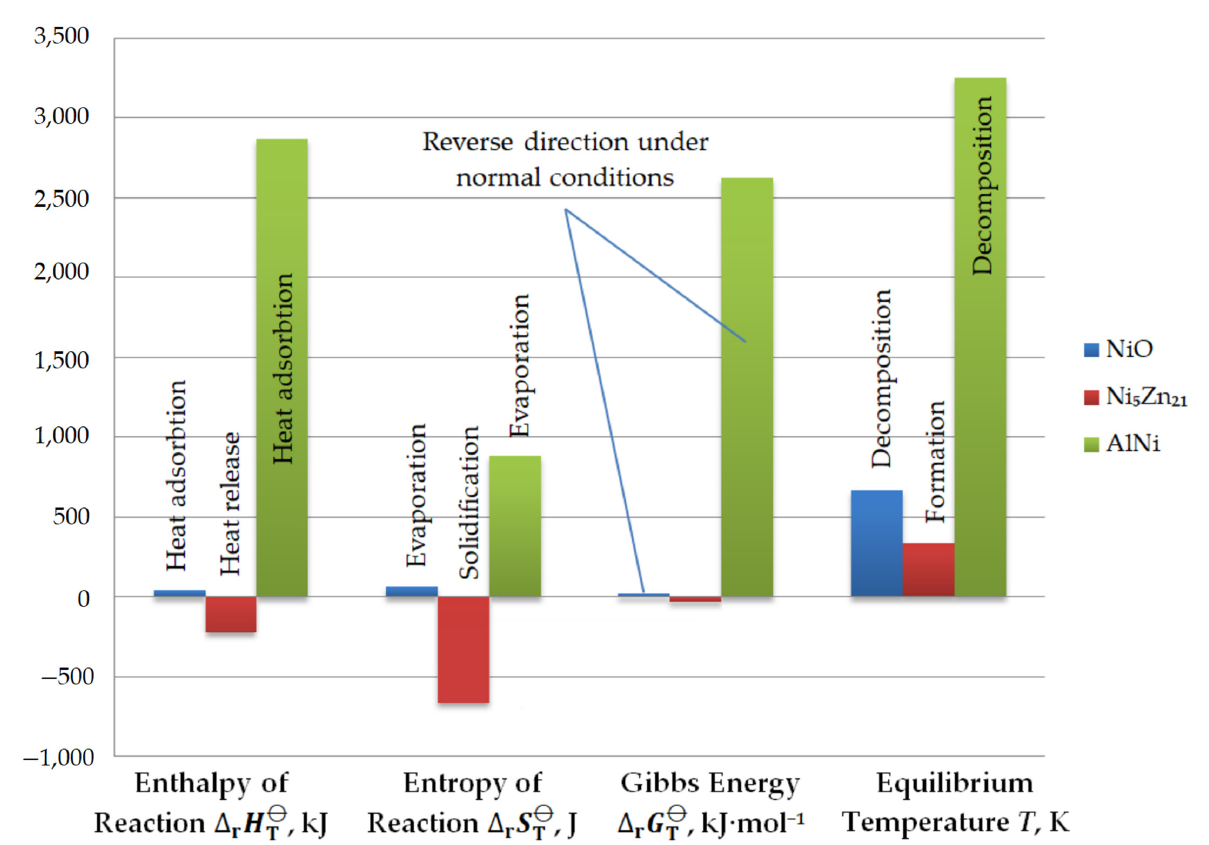
Figure 9. Thermochemical parameters of chemical reactions of nickel with some components of water medium (oxygen), brass wire tool (zinc) and dielectric workpiece (alumina).